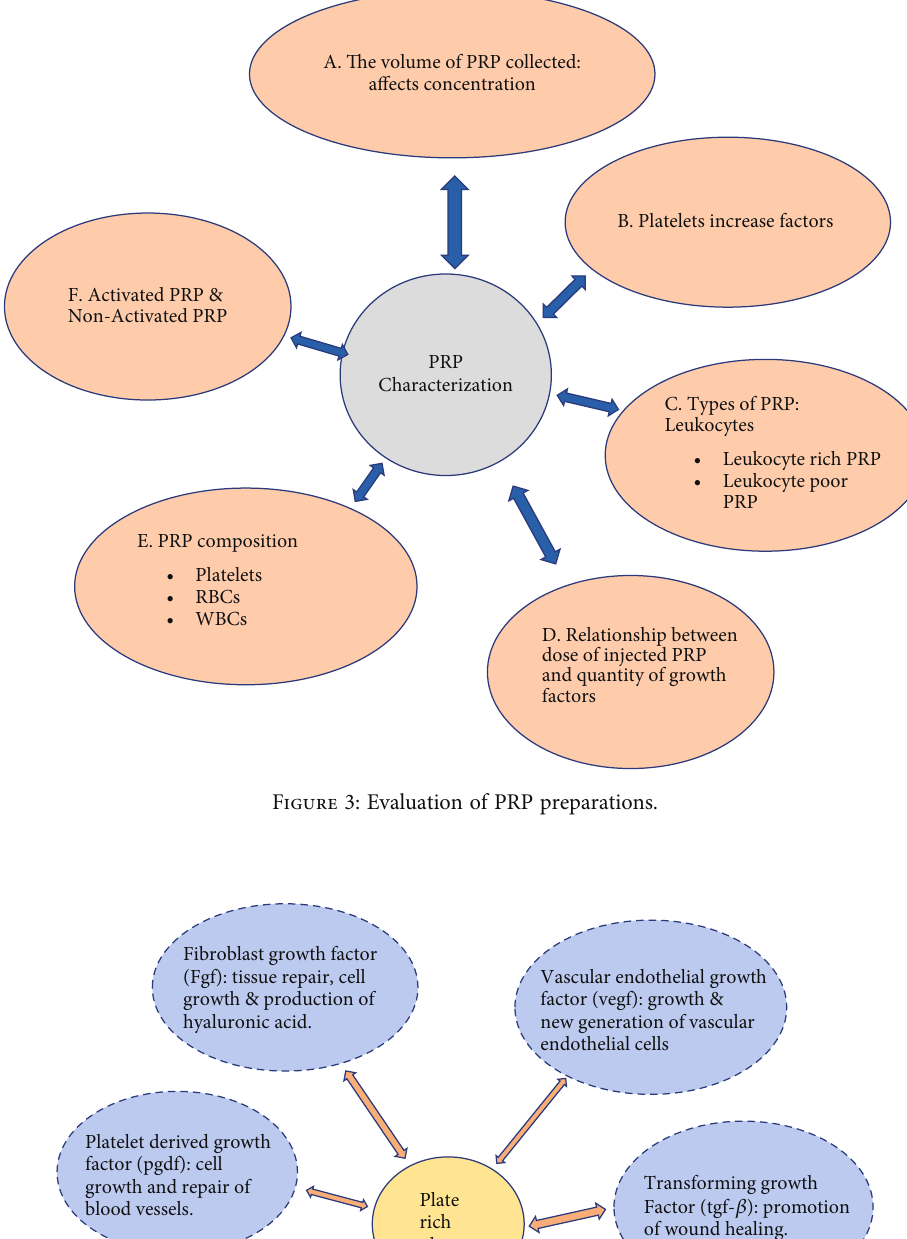
Figure 4: PRP components and